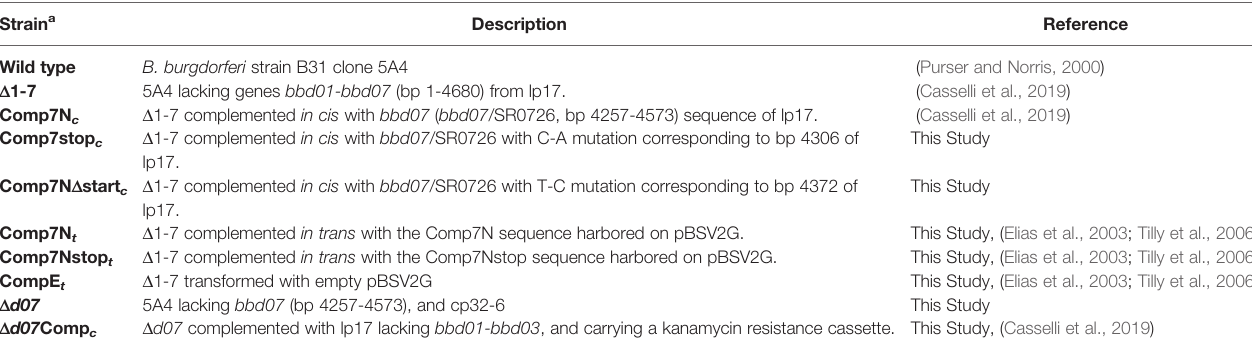
TABLE 1 | B. burgdorferi strains used in this